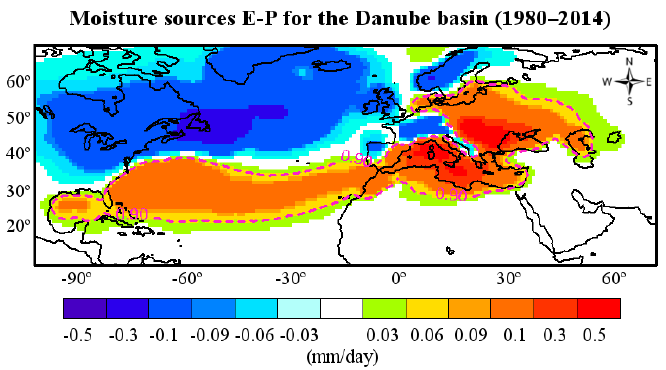
Figure 3. Climatological annual 10-day integrated ( E-P ) obtained from the backward DRB experiment for the period October 1980 to September 2014. The pink dashed contour line delimits the source areas selected using the 90th percentile of the ( E-P ) > 0 values (i.e., 0.06 mm/day).